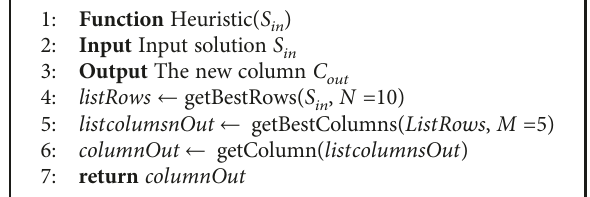
Algorithm 5: Heuristic